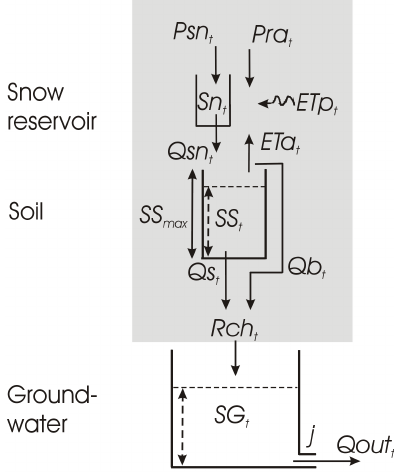
Figure 1. Model set-up of the conceptual hydrological model used in this study. The model consists of three partitions, Snow, Soil and Groundwater. P sn snowfall, P ra rainfall, ET p potential evapotran- spiration, ET a actual evapotranspiration, S n snow storage, SS soil storage, SS max maximum soil storage, Q sn snowmelt, Q s recharge to the groundwater from the unsaturated zone, Q b bypass flow, R ch total recharge to groundwater, SG groundwater storage, j ground- water response parameter, Q out groundwater discharge and t is the time